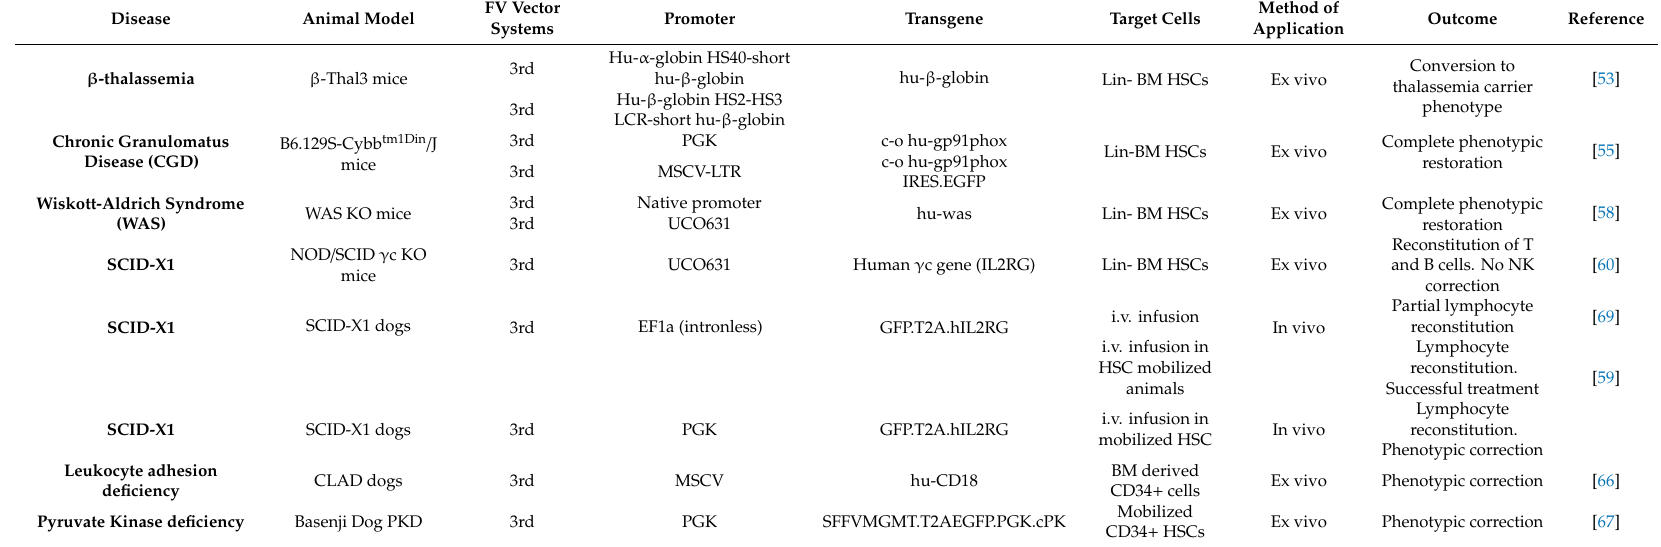
Table 2. Gene therapy trials with FV-derived